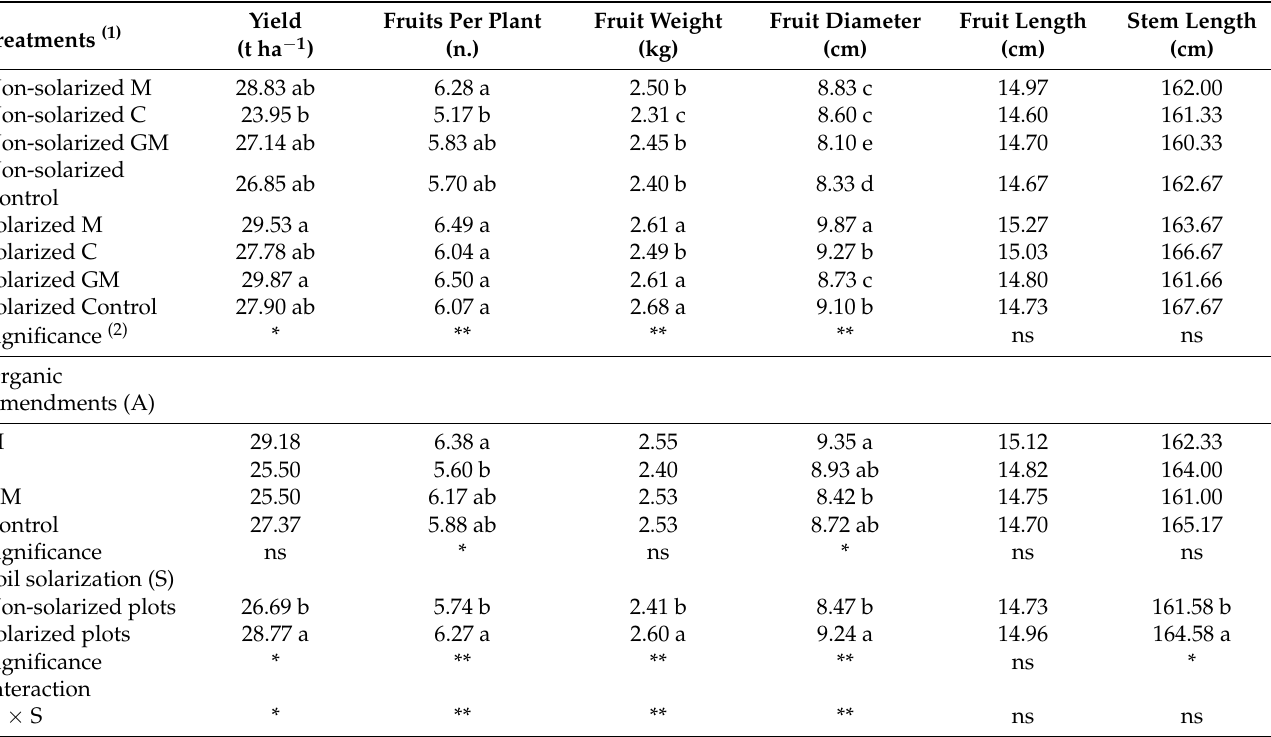
Table 2. Effects of organic amendments and soil solarization on yield and some morphological traits of